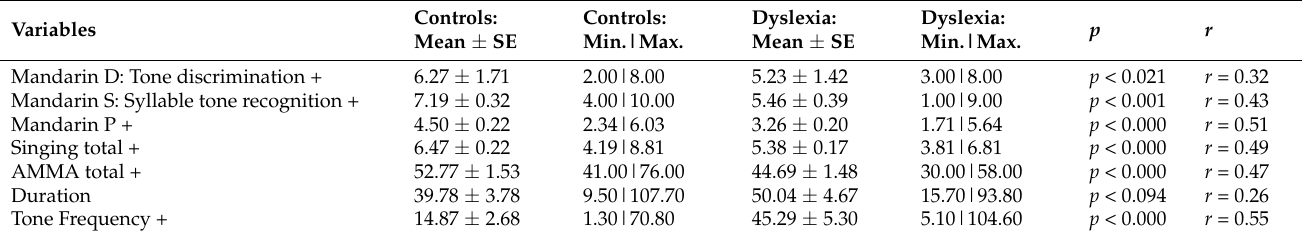
Table 3. The independent t -tests and the descriptives of the variables of the investigation.